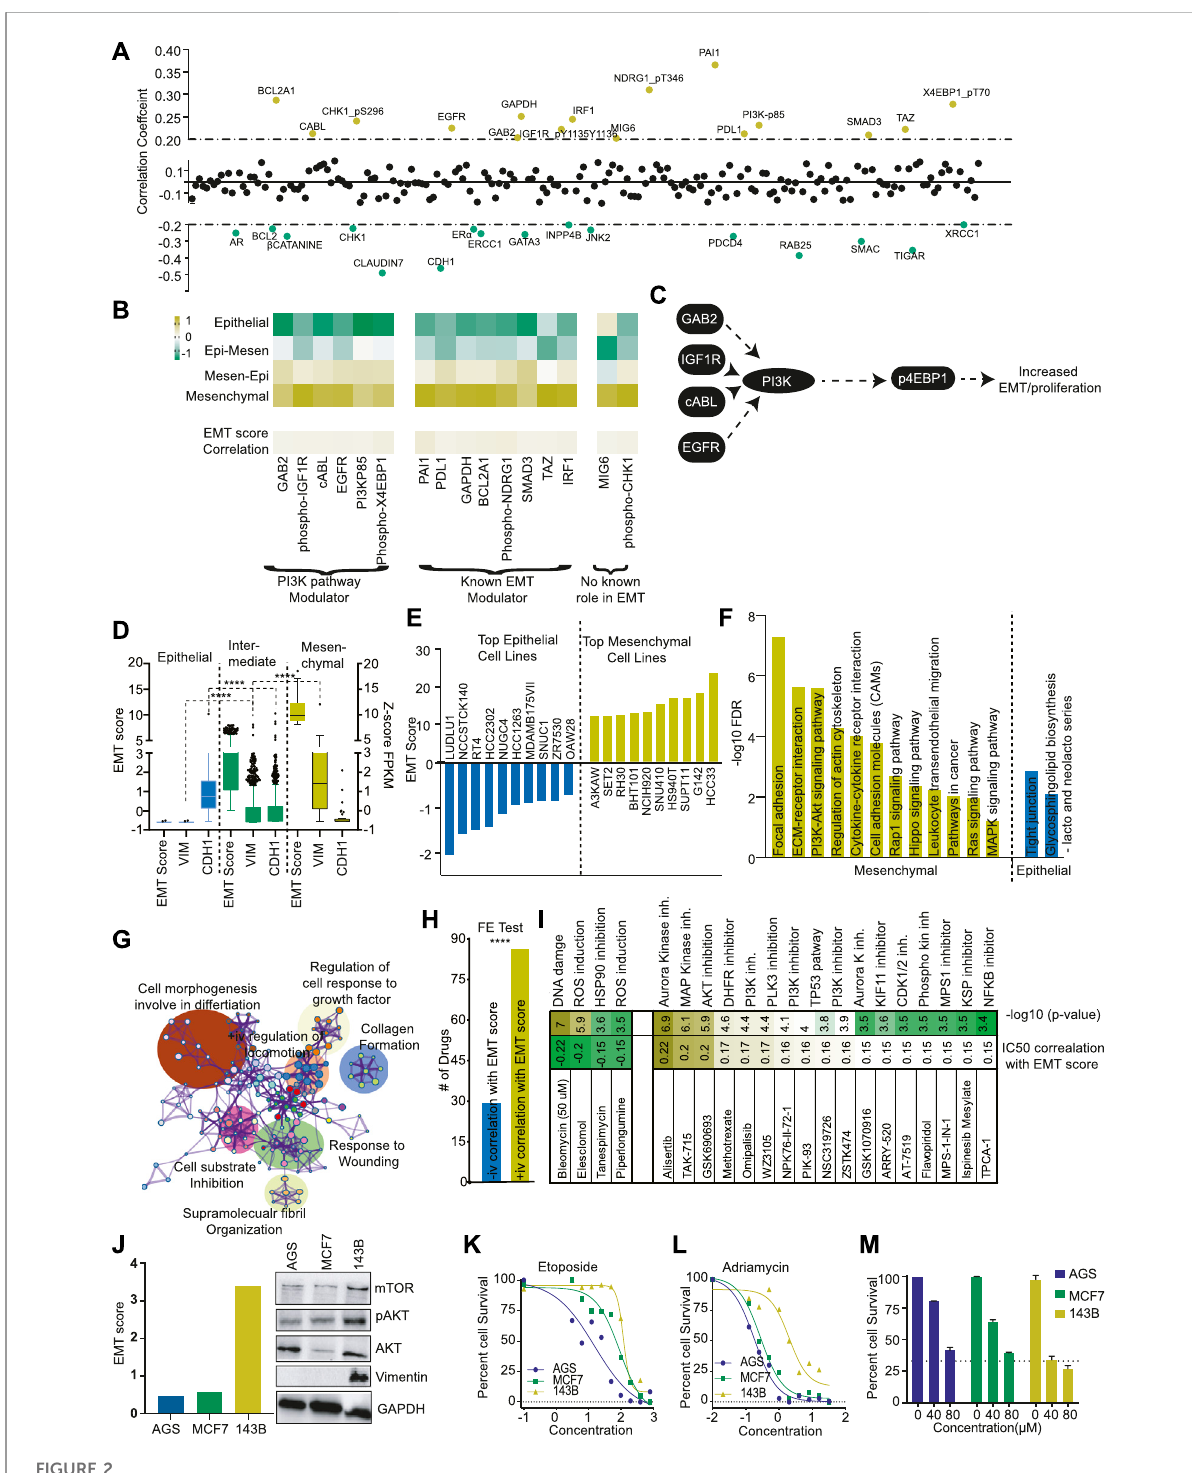
Pi3K pathway plays a major role in mesenchymal phenotype. (A) The correlation of EMT score with protein expression data of TCGA patients wascalculatedandplotted.TheYellowdotsrepresentthepositivecorrelation( > +0.2),andthegreendotsrepresentthenegativecorrelation( < − 0.2). (B) The average expression of proteins with a positive correlation with the EMT score was plotted as a heatmap for each EMT class. The proteins are divided into three classes depending upon their role in the PI3K pathway and EMT. (C) A diagram showing the PI3K pathway modulator with a positive correlation with the EMT score. (D) EMT score for each CCLE cell line was calculated, and cells were divided into epithelial, mixed, and mesenchymal groups. The expression of VIM and CDH1 was compared in three groups and plotted. (E) EMT score for each CCLE cell line